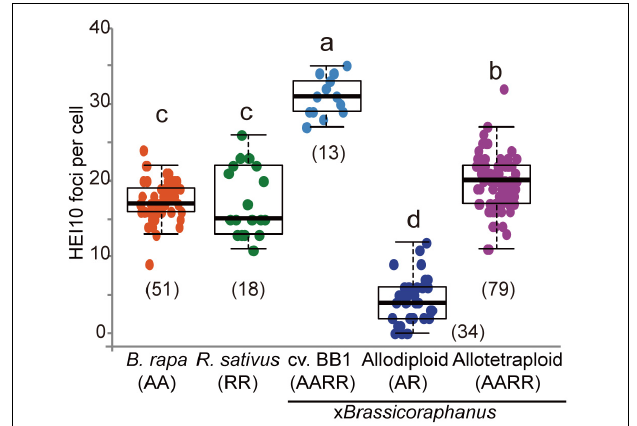
FIGURE 5 | The number of HEI10 foci per PMC at pachytene. The parental species showed similar number of HEI10 foci (17.54 ± 3.48 in B. rapa and 17.33 ± 4.51 in R. sativus ). BB1 represented twice number of HEI10 foci than parental species (30.92 ± 2.53 in BB1) and slightly low number of foci were observed in resynthesized allotetraploid x Brassicoraphanus (19.74 ± 3.52). In synthetic allodiploid x Brassicoraphanus , only few foci were detected (4.38 ± 2.97). The numbers of observed PMCs were represented in parenthesis. One way analysis of variance (ANOVA) showed differences among treatments ( p < 2.5e - 18 ) and letters indicate the differences followed by Duncan test ( p <